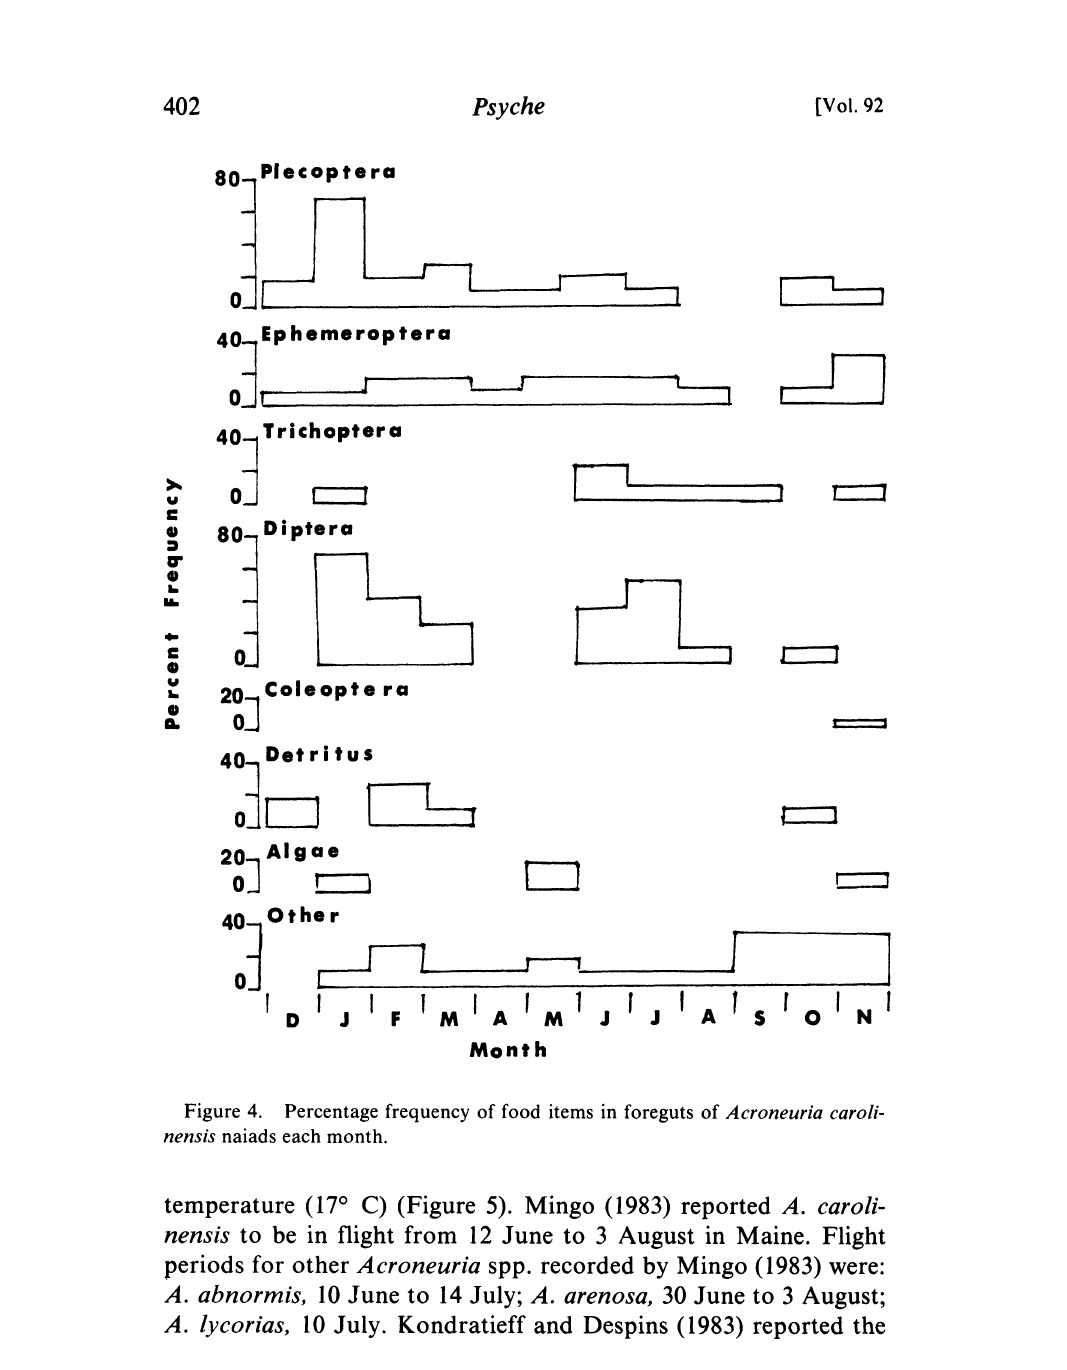
Figure 4. Percentage frequency of food items in foreguts of Acroneuria caroli- nensis naiads each month. temperature (17 C) (Figure 5). Mingo (1983) reported A. carol# nensis to be in flight from 12 June to 3 August in Maine.